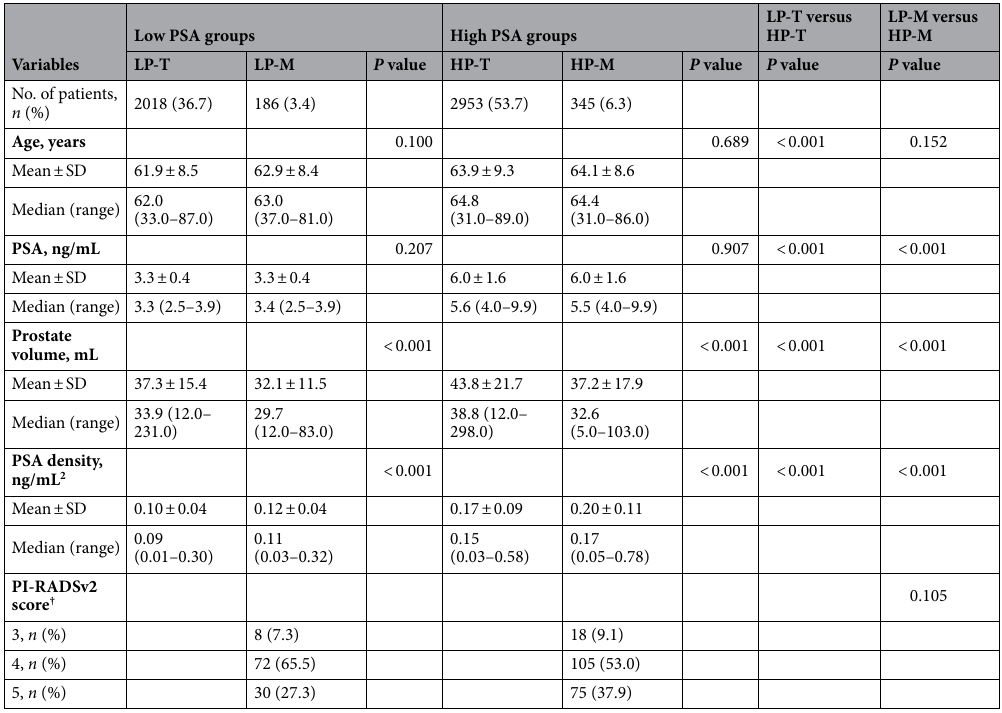
Table 1. Clinical characteristic of men who underwent prostate biopsy. PSA Prostate-specific antigen, TRUS-Bx Transrectal ultrasound-guided biopsy, MRI-TBx magnetic resonance imaging-targeted biopsy, PI-RADSv2 Prostate imaging reporting and data system version 2, SD Standard deviation. Groups: LP-T (men with PSA 2.5–4.0 ng/mL who underwent TRUS-Bx); LP-M (men with PSA 2.5–4.0 ng/mL who underwent MRI-TBx); HP-T (men with PSA 4.0–10.0 ng/mL who underwent TRUS-Bx); HP-M (men with PSA 4.0– 10.0 ng/mL who underwent MRI-TBx). † PI-RADSv2: LP-M ( n = 110), HP-M ( n =